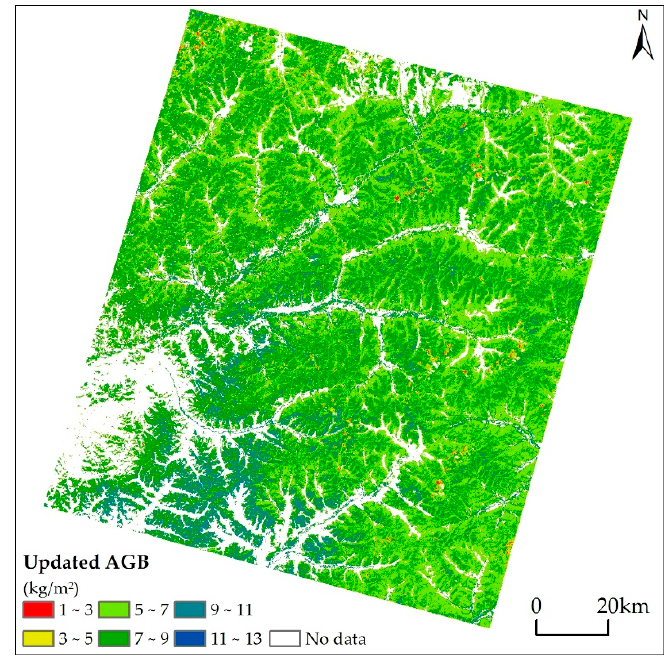
Figure 5. The BEPS-based forest AGB for 2012. Sensors 2017 , 17 , 2062